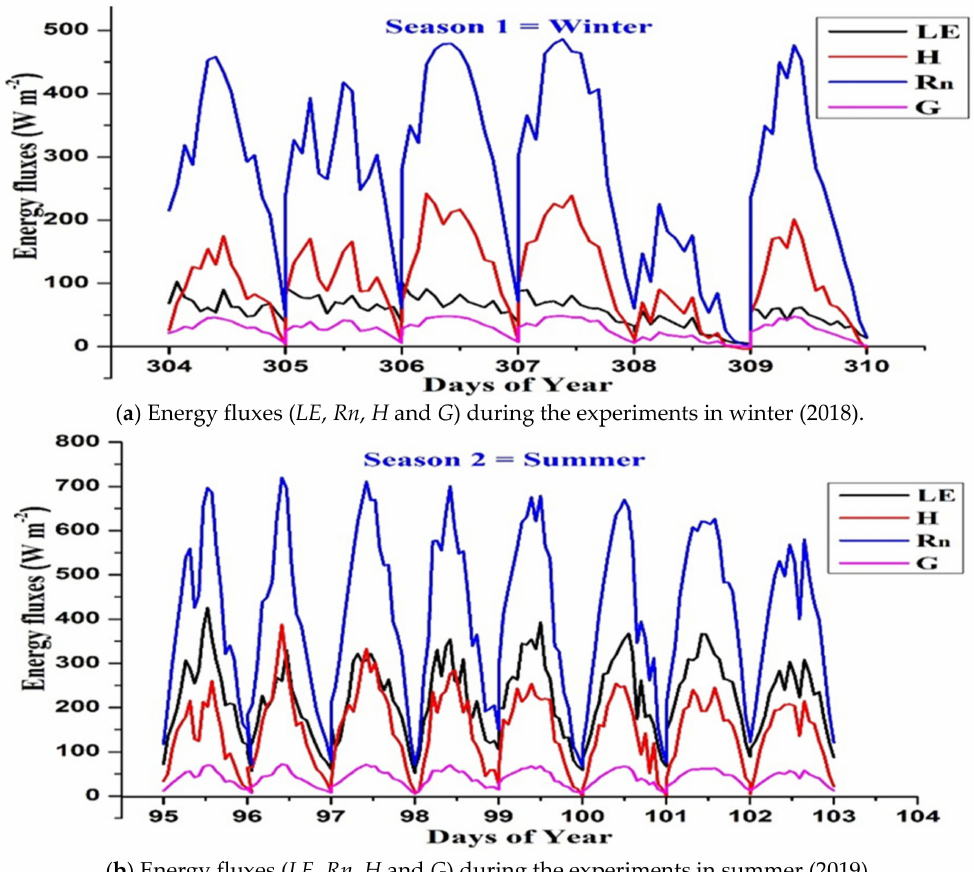
Figure 4. Energy fluxes ( LE , Rn , H and G ) during the experiments in both seasons. ( a ) Season 1, winter (2018). ( b ) Season 2, summer (2019).